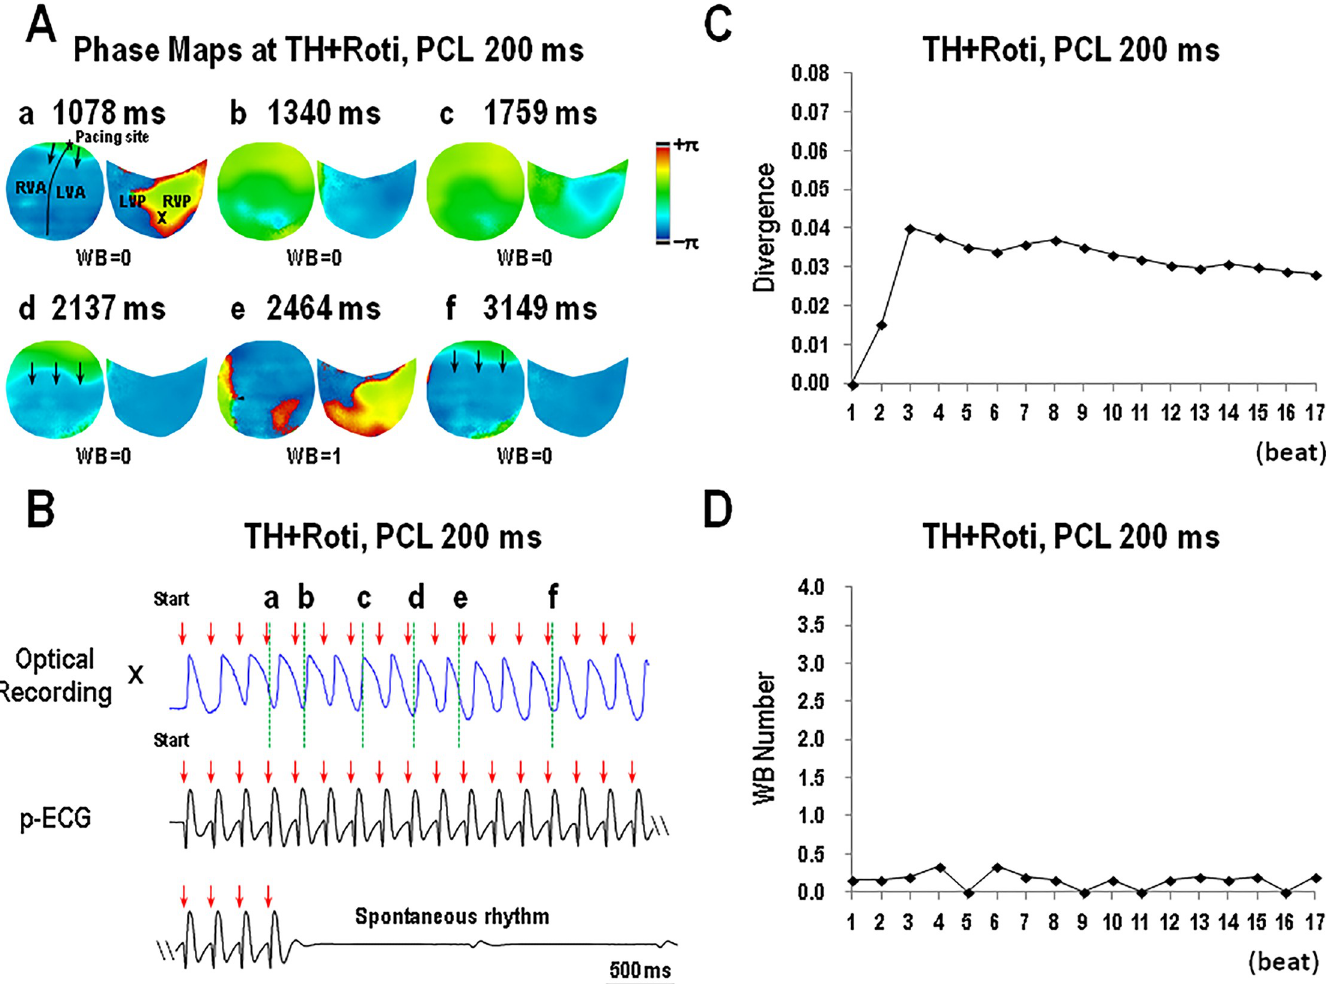
Fig 6. Simultaneous recordings of epicardial activations (A), pseudo-ECG (B), dynamic changes of divergence (C), and epicardial wavebreaks (D) at the start of burst ventricular pacing at pacing cycle length (PCL) 200 ms during therapeutic hypothermia (TH, 30˚C) in an episode of low divergence (data is from heart #7). Note that the divergence increased to 0.040 at the 3 rd beat and decreased to 0.028 at the 17 th beat. VF was not inducible in this episode (B). Black triangles in panel A indicate points of wavebreaks (WBs). https://doi.org/10.1371/journal.pone.0228818.g006 PLOS ONE | https://doi.org/10.1371/journal.pone.0228818 February 21,